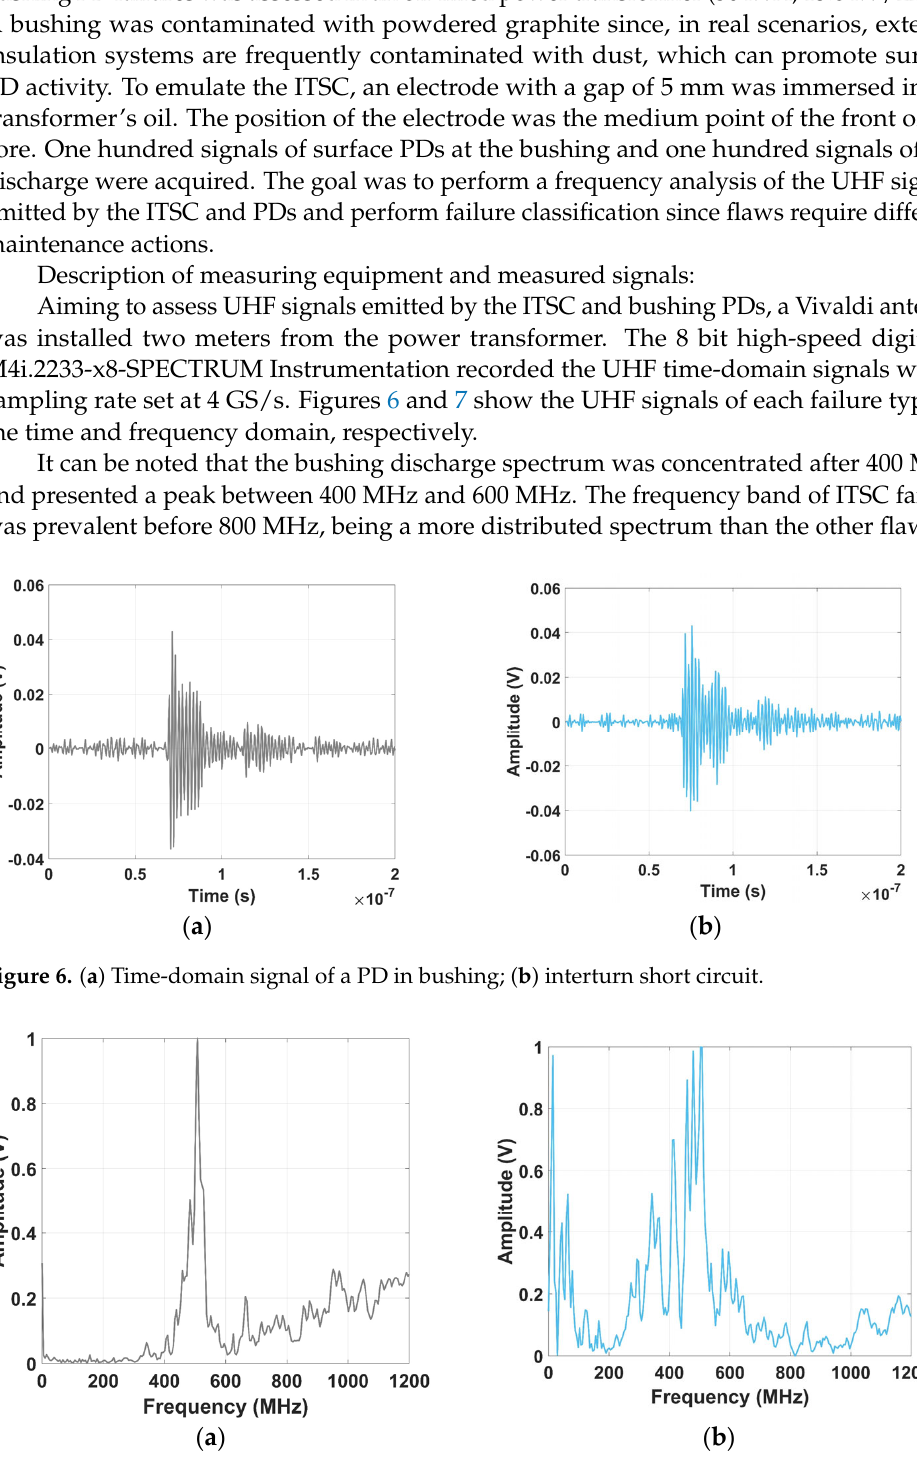
Figure 7. ( a ) Spectrum of a PD in bushing; ( b ) interturn short circuit.